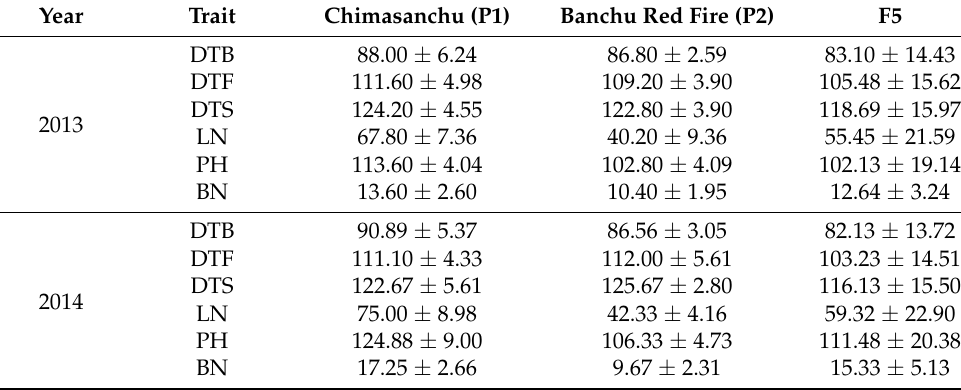
Table 1. Average ( ± SD) and statistical analysis of the number of days from sowing to bolting (DTB), the number of days from sowing to flowering of the first flower (DTF), the number of days from sowing to seed setting of the first flower (DTS), total number of leaves (LN), plant height (PH) when the first flower fully opened, and total number of branches of main inflorescence (BN) of Lactuca sativa L. cv. Chimasanchu (P1), Lactuca sativa L. cv. Banchu Red Fire (P2), and F5 RIL population. Year Trait Chimasanchu (P1) Banchu Red Fire (P2) F5